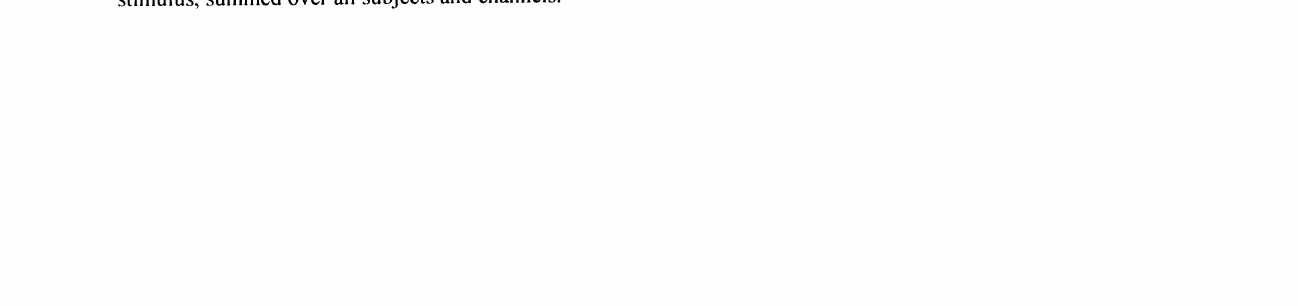
Fig. 2: A) Local rms-signal at latency 100 to 900 ms after the choice stimulus (rms-signal has been summed over an interval of 10 ms). The sequence shown is based on data from two subjects (first subject 100- 400 ms; second subject 500- 900 ms) to illustrate the significant stages of neural activity. Due to inter-subject variability, not all regions mentioned in the text are visible. For the presentation of data, the helmet-shaped array of detectors has been projected into two dimensions the left, front at the top). Inset: The helmet-shaped array of detectors. Each plate symbolizes two orthogonal, first-order gradiometers most sensitive to directly underlying neural currents. B) Global rms-signal (arbitrary units) after the choice stimulus, summed over all subjects and